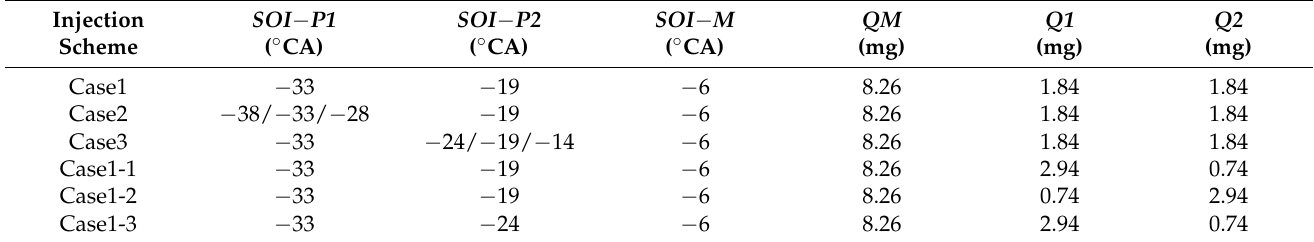
Table 5. Injection timing for various injection